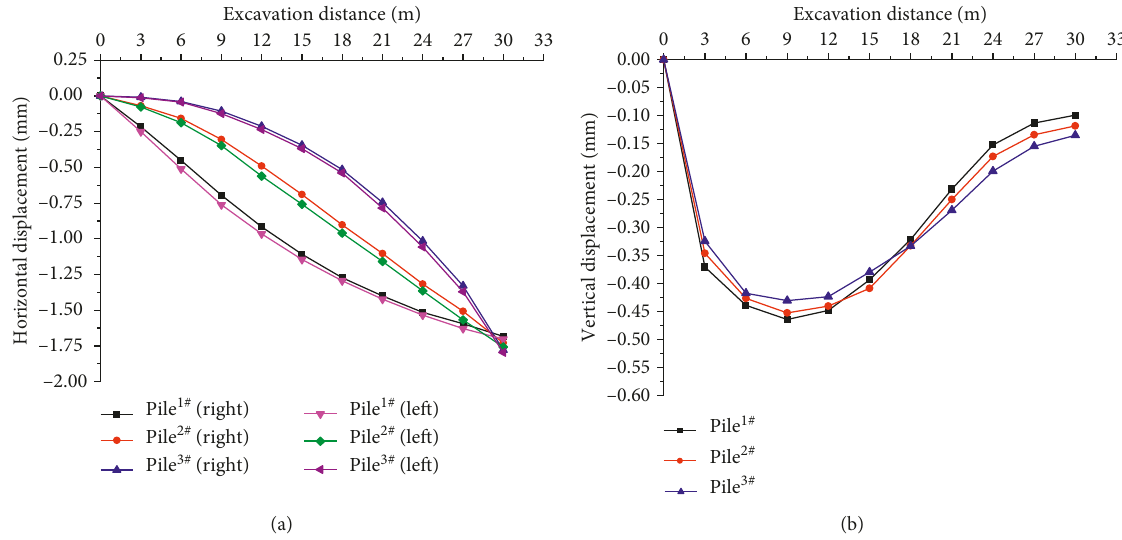
Figure 5: Displacement at the pile top under different excavation distances: (a) horizontal displacement; (b) vertical displacement.